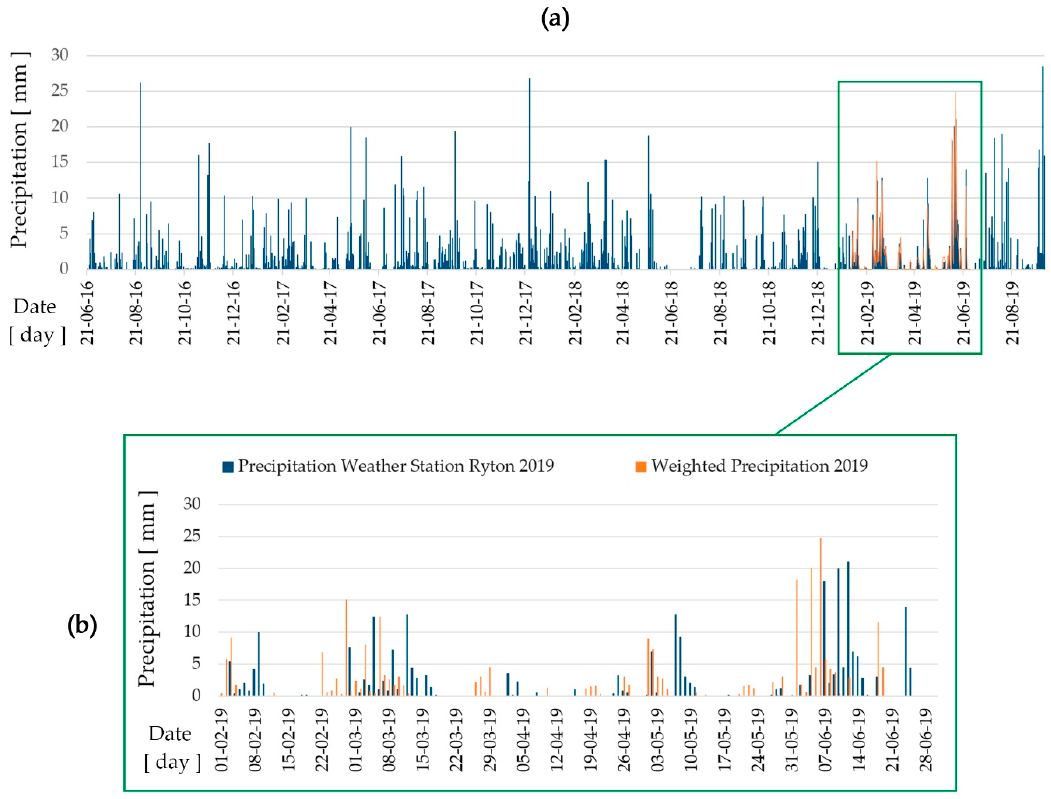
Figure 4. Weather data at the experimental site for ( a ) the entire monitoring period and ( b ) the 6 months of calibration.